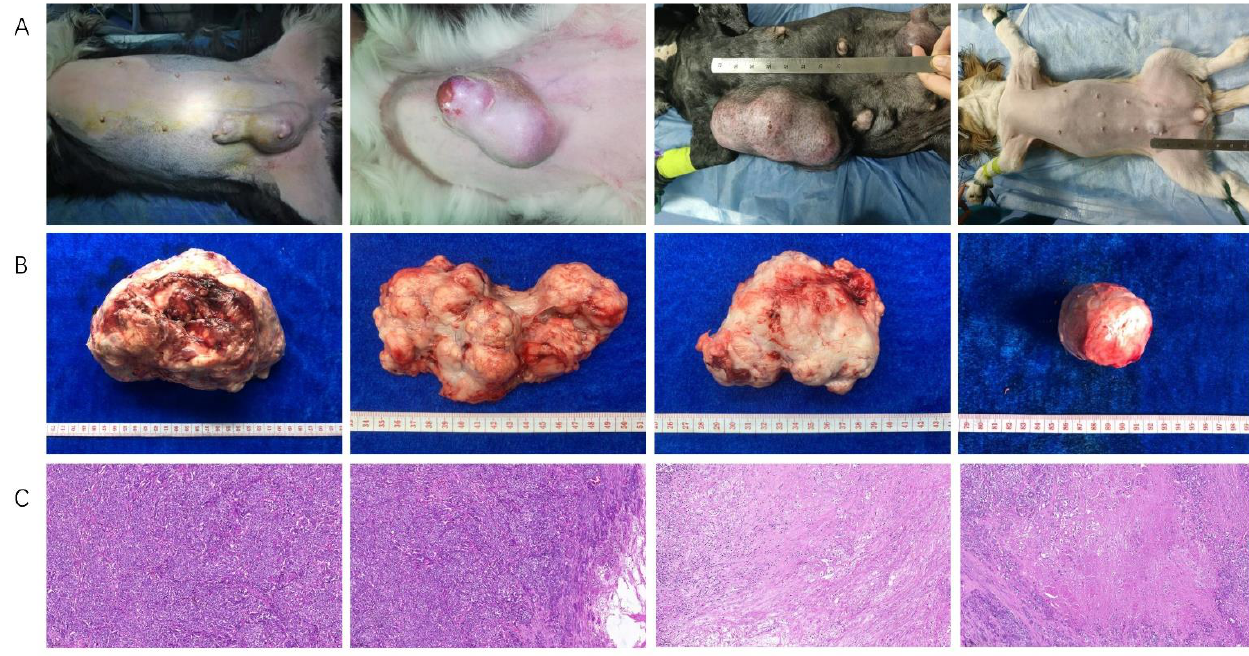
Figure 1. The feature of dogs with canine mammary tumors. ( A ) The clinical features of canine mammary tumors in dogs, and single and multiple tumor(s) were observed in a dog; ( B ) The sizes and shapes of canine mammary tumors after an excisional mastectomy, and the different sizes, unclear boundaries and irregular shapes were observed in vitro; ( C ) Histopathological diagnosis of canine mammary tumors in dogs, which were the cell morphology under low magnification (100 ×